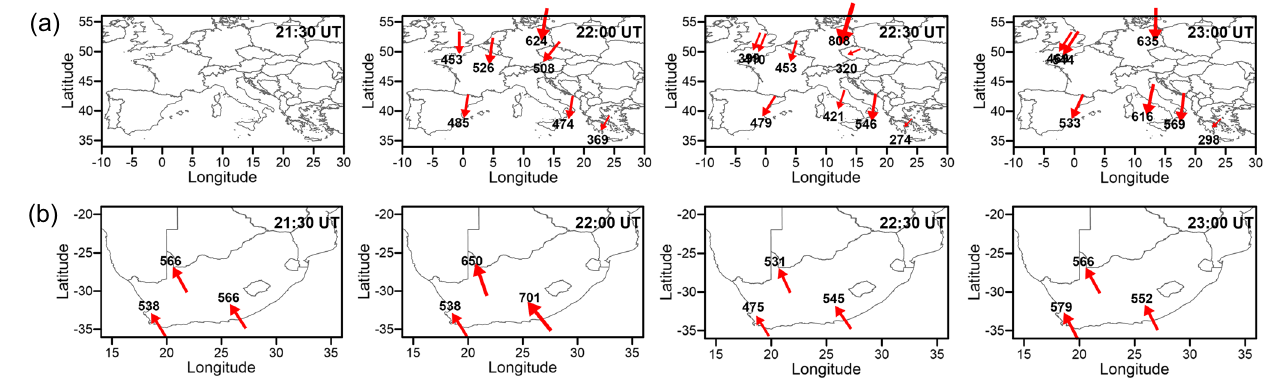
Fig. 8. Maps of the estimated velocity vectors of the LSTID event detected over (a) Europe and (b) South Africa on 12 October 2015 for the indicated times. Length of arrows is proportional to the velocity values which is show in the Table 3. Characteristics of the LSTID observed in Europe for the night of 12 – 13 October 2015 with independent methodologies and different data. Azimuth is counted clockwise from the true North.